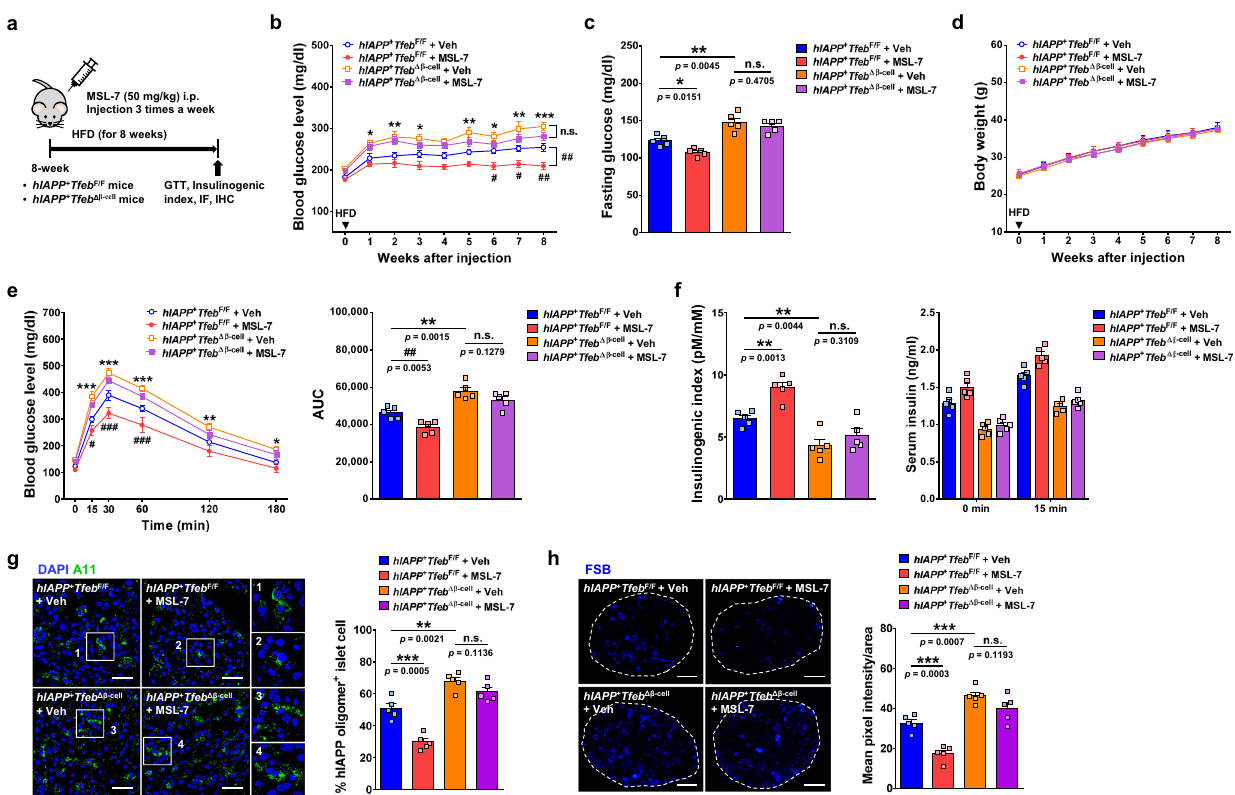
Fig. 7 Role of pancreatic β -cell Tfeb in MSL-7-induced metabolic improvement. a Scheme of MSL-7 administration to hIAPP + Tfeb Δβ -cell mice. b Nonfasting blood glucose was monitored weekly during MSL-7 treatment ( F = 28.0, df = 3). ( n = 5 each). c Fasting blood glucose in HFD-fed hIAPP + Tfeb Δβ -cell and hIAPP + Tfeb